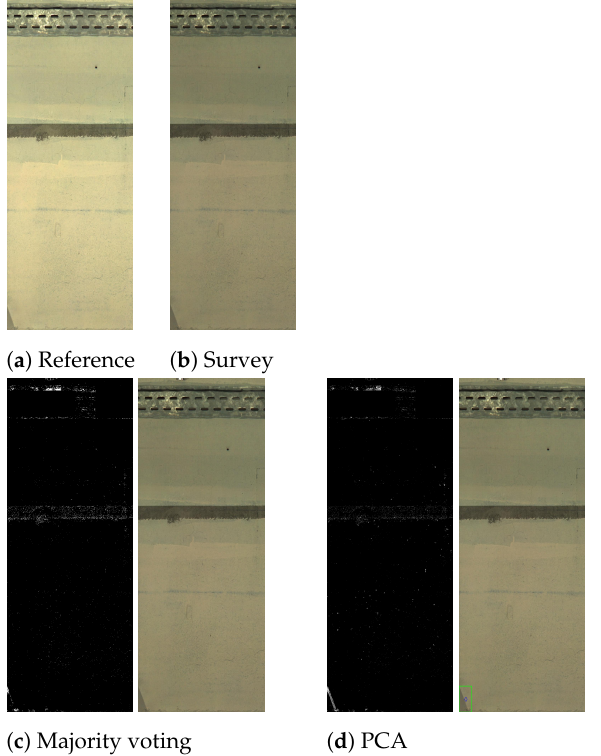
Figure 21. An example exhibiting lighting changes that are correctly identified as a nuisance and not detected as a change. Reference ( a ), survey ( b ), majority voting ( c ) and PCA ( d